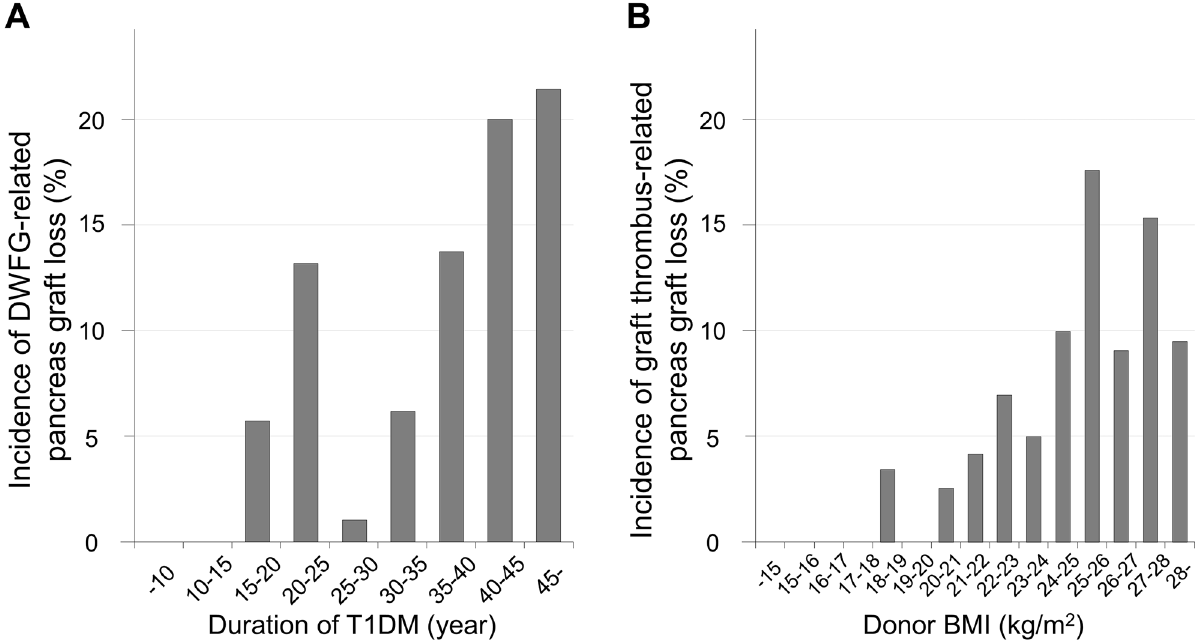
mellitus. ( B ) Incidence of graft thrombus-derived pancreas graft loss based on donor BMI. BMI Body mass index, DWFG death with a functioning